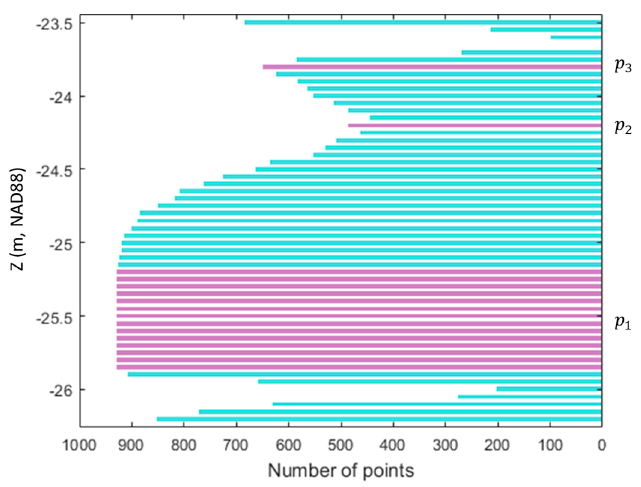
Figure 3. Examples of detected peaks ( 𝑝 (cid:2869) , 𝑝 (cid:2870) , and 𝑝 (cid:2871) ) in the inverse histogram. Algorithm 1. Peak Detection Method